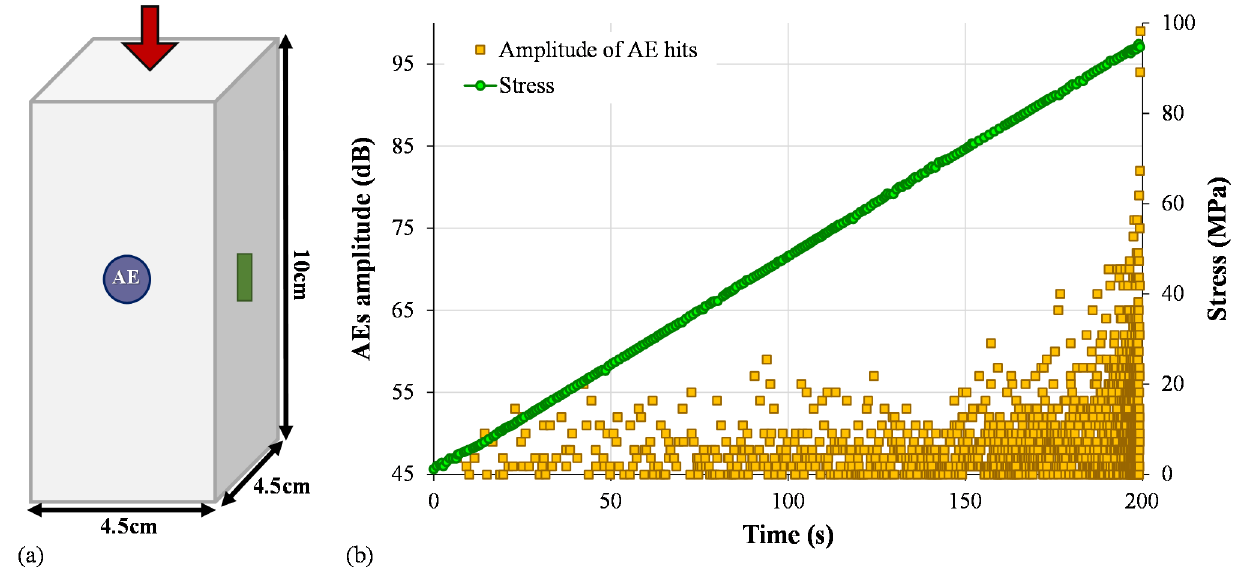
Figure 6. ( a ) Sketch of the intact prismatic specimen. The red arrow indicates the direction of the imposed load and the green rectangle the strain gauge. ( b ) The temporal evolution of the amplitudes of the acoustic hits in juxtaposition to that of the compressive force imposed. Proper fitting of the data gives the exponent m a value equal to m = 5.26. The range of applicability of the power law covers the interval from χ = 0.58 to χ = 0.93. The corresponding conventional-time interval extends from t = 189 s to t = 198 s, while the corresponding values of the axial stress are 89.9 MPa and 94.2 MPa, respectively, or, equivalently, 94% and 99% of the material’s compressive strength.